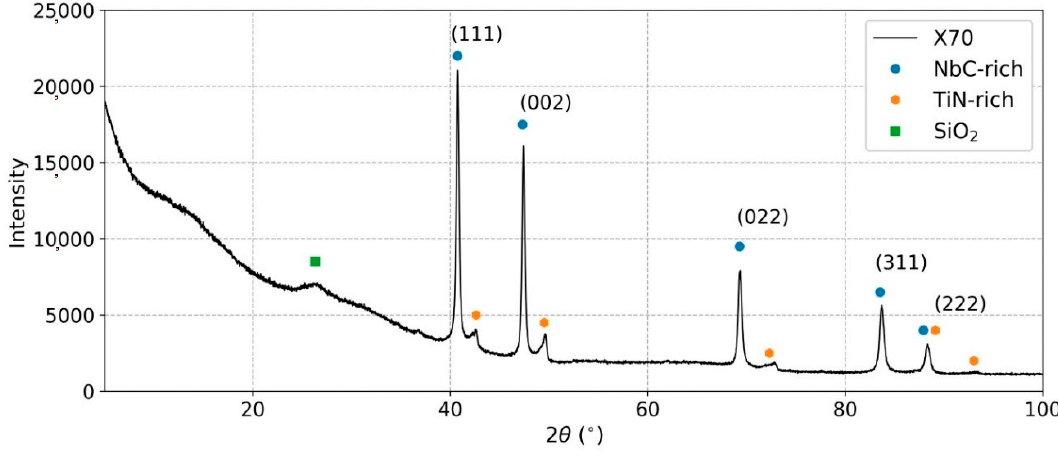
Figure 6. XRD pattern from X70 steel residue.